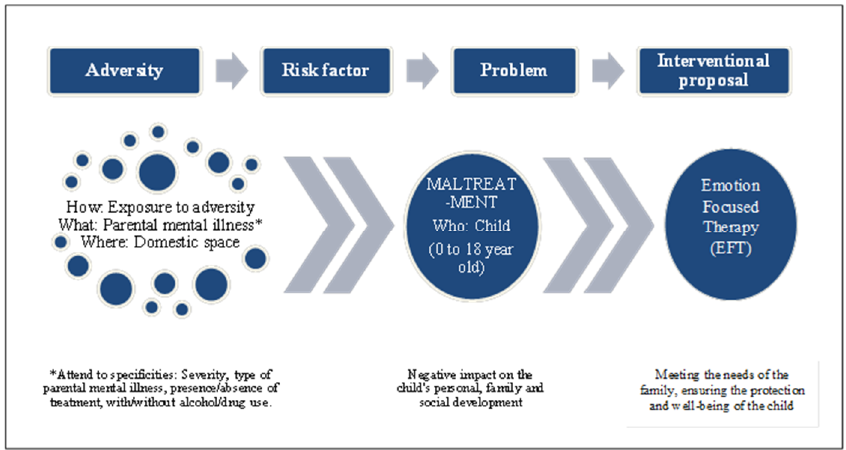
Figure 1. Schematic overview of the analytical and theoretical dimensions of the proposal under discussion.